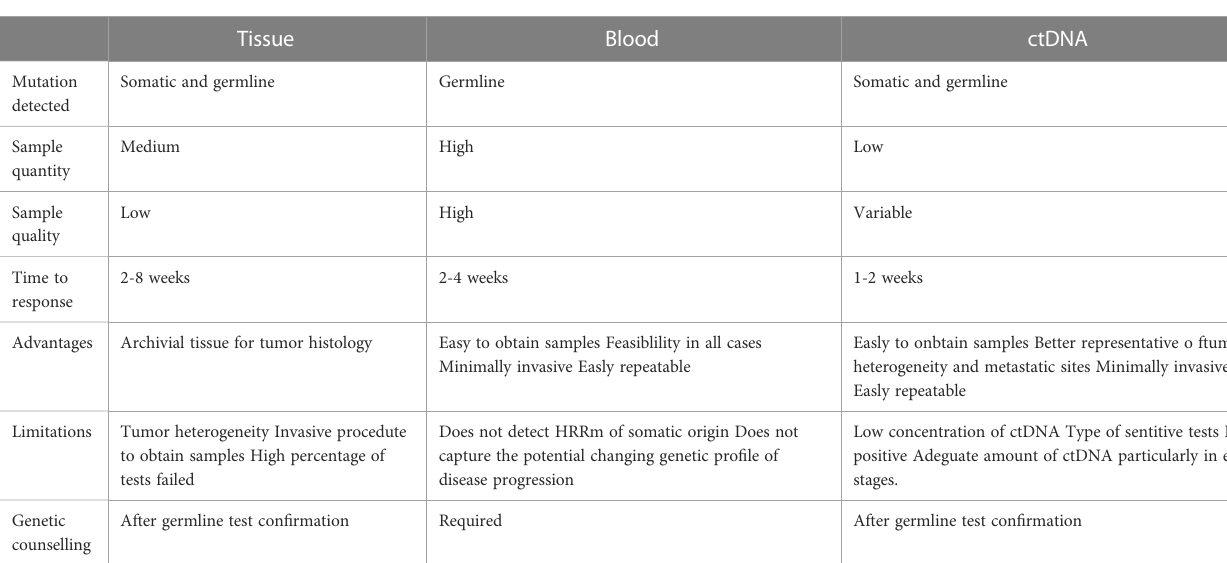
TABLE 1 Pros and cons of tissue, blood, and ctDNA-based HHR gene